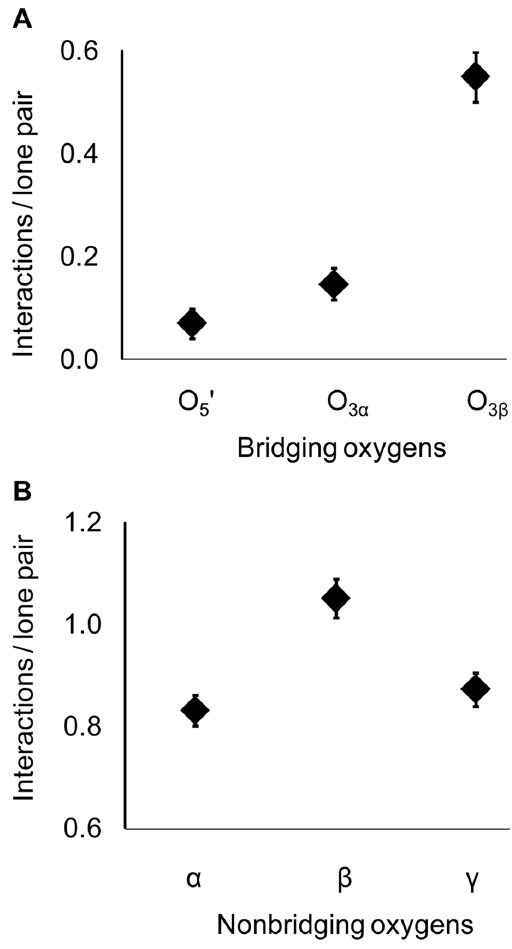
Figure 11. Saturation of NTP oxygen lone pairs by enzyme or solvent interactions in O 3 b —P c -cleaving active sites. Bars denote standard errors.